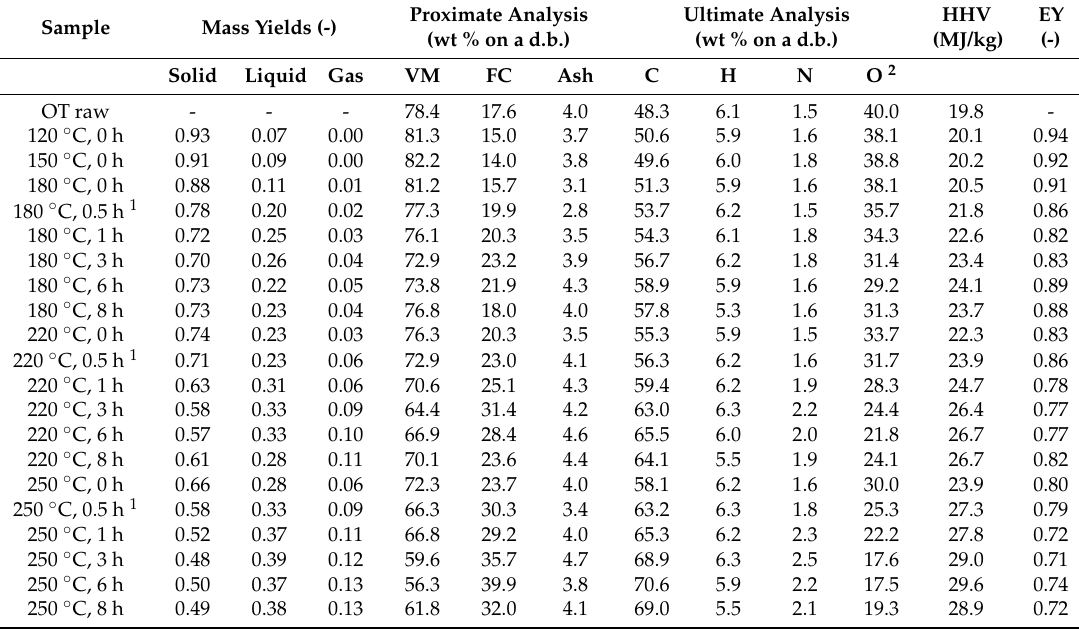
Table 1. Mass yields, proximate and ultimate analyses, and HHV of raw feedstock and hydrochars. Analyses were performed in duplicate. Average values are shown (Er < 2.0% for solid yields; Er < 3.2% for proximate, and Er < 0.6% for ultimate analyses; Er < 1.0% for